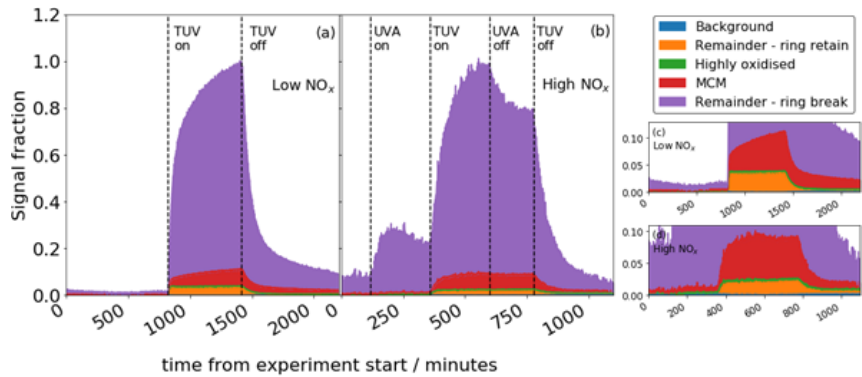
Figure 9. Total signal from CHON + CHO compounds for the low-NO x (a) and high-NO x (b) experiments. Panels (c) and (d) show the same data in (a) and (b) with a reduced y scale; y and x scale have the same units.